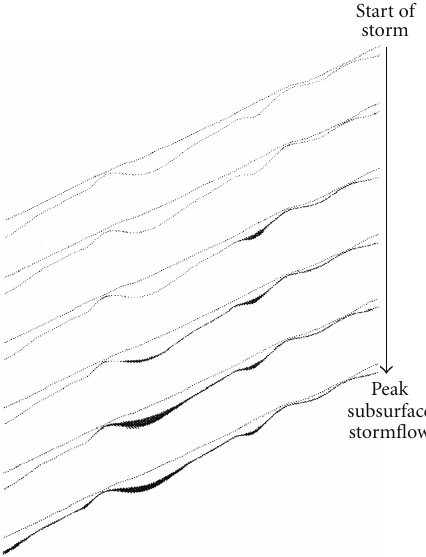
Figure 2: Schematic representation of the fill and spill process. The shaded areas represent the locations of subsurface saturation. The vertical exaggeration is 2 times